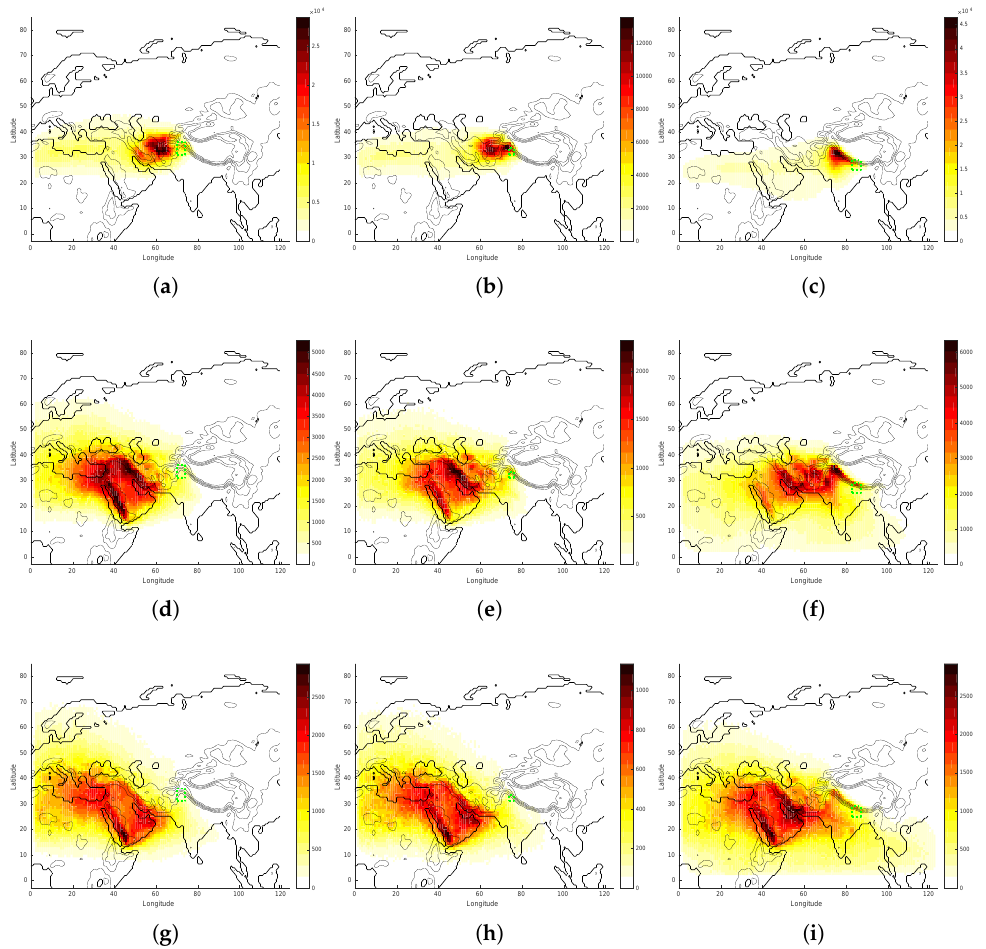
Figure 9. Winter (NDJ) column integrated climatology (1980–2016), of the parcel density, for all parcels over each 1 ◦ area, originating from: ( a ) NP , 2 days back in time, along the parcel trajectory; ( b ) U , 2 days back in time, along the parcel trajectory; ( c ) K , 2 days back in time, along the parcel trajectory; ( d ) NP , 6 days back in time, along the parcel trajectory; ( e ) U , 6 days back in time, along the parcel trajectory; ( f ) K , 6 days back in time, along the parcel trajectory; ( g ) NP , 10 days back in time, along the parcel trajectory; ( h ) U , 10 days back in time, along the parcel trajectory; ( i ) K , 10 days back in time, along the parcel trajectory. The area of interest is illustrated by a green dashed